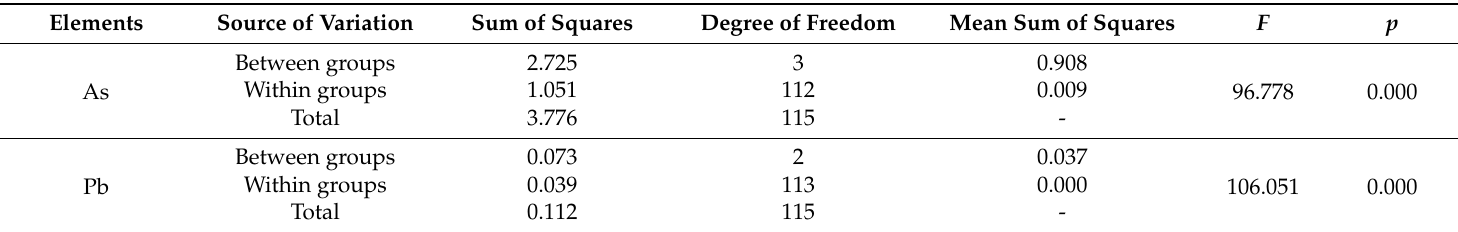
Table 5. Parameters of the prediction model derived from the empirical relationships between the heavy metal concentrations and FDR spectra. Elements Wavelength (nm)